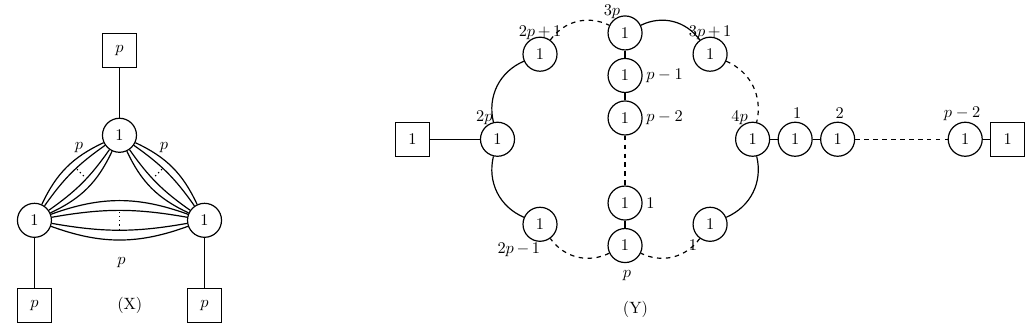
Figure 35 . The pair of Lagrangian theories associated with the 3d N = 4 SCFT that arise from the dimensional reduction of an ( A ) AD theory on a circle, for s = 3 and generic p . s , A ( s +1) p − 1 Quiver ( X ) was obtained using class S construction of AD theories, while quiver ( Y ) is the proposed 3d mirror dual of quiver ( X ) .